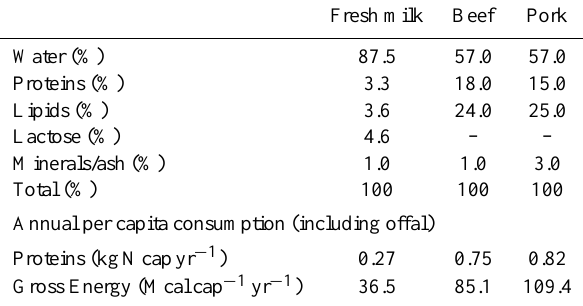
Table 1. Composition of fresh milk, beef and pork and correspond- ing annual energy (Mcalcap − 1 yr − 1 ) and protein (kgNcapyr − 1 ) consumption. Data sources: see in the text.